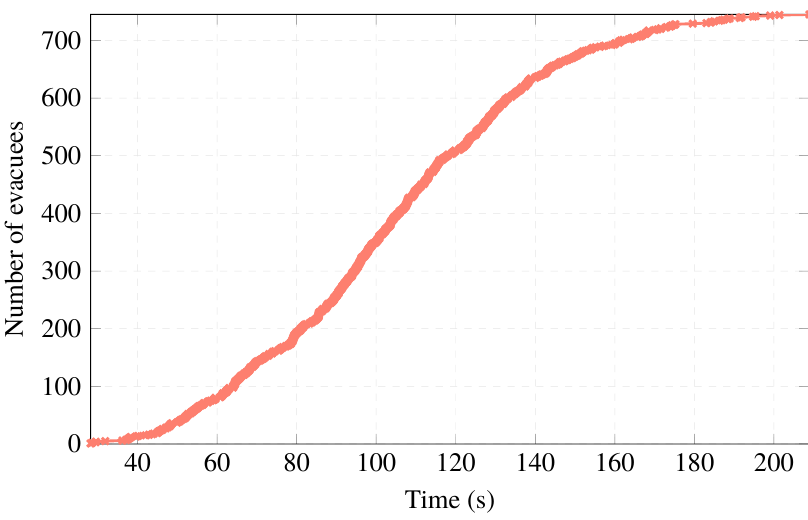
Figure 8. Dispersion diagram, time per number of evacuees (GQ situation, SIMONE).